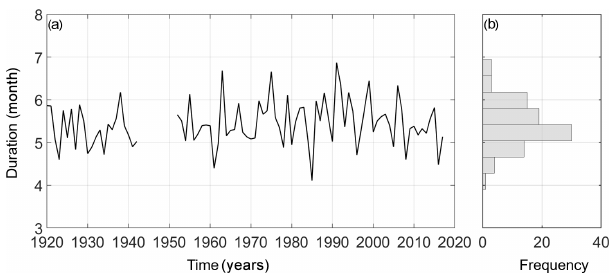
Figure 7. Temporal evolution of the centroid (or timing; solid line) and spread (or duration; dashed lines) of the wet seasons estimated as proposed by Feng et al. (2013) within the framework of the dy- namic approach (rainfall data were recorded at the Gioi Cilento weather station).